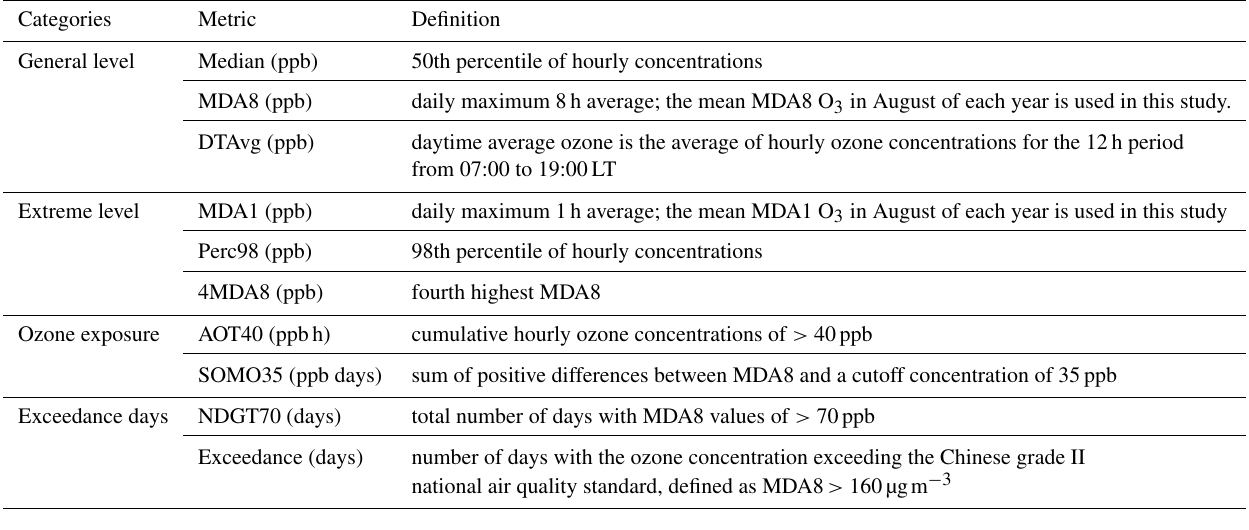
Table 3. Description of Ozone Metrics used in this study.